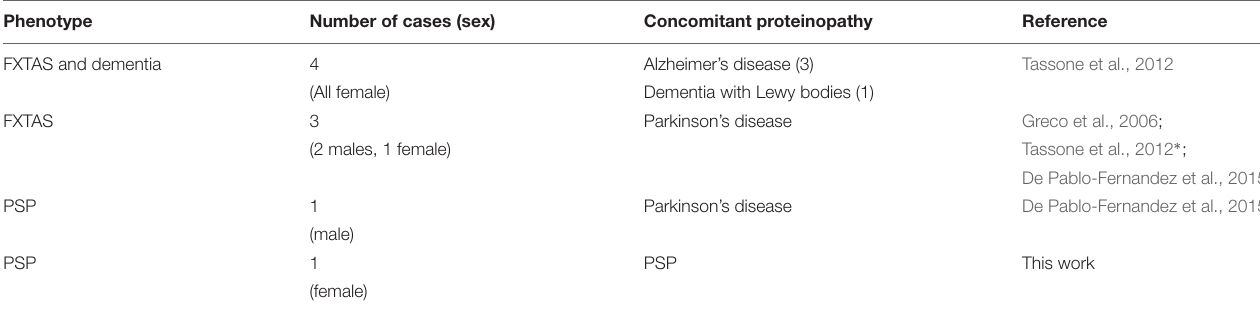
FIGURE 4 | Tau staining with the AT8 antibody, demonstrating phosphorylated tau. In frontal cortex (A) and tectum (B) , tufted astrocytes were frequently found. In the white matter, there were many oligodendroglial coiled bodies along with thread-like structures (C) . Several neurons in locus coeruleus showed dense tau staining (D) . 4R tau staining in tufted astrocytes in the frontal cortex was evident (E) . Scale bars: 25 µ m. TABLE 1 | Summary of FMR1 premutation carriers with pathologically-confirmed concomitant